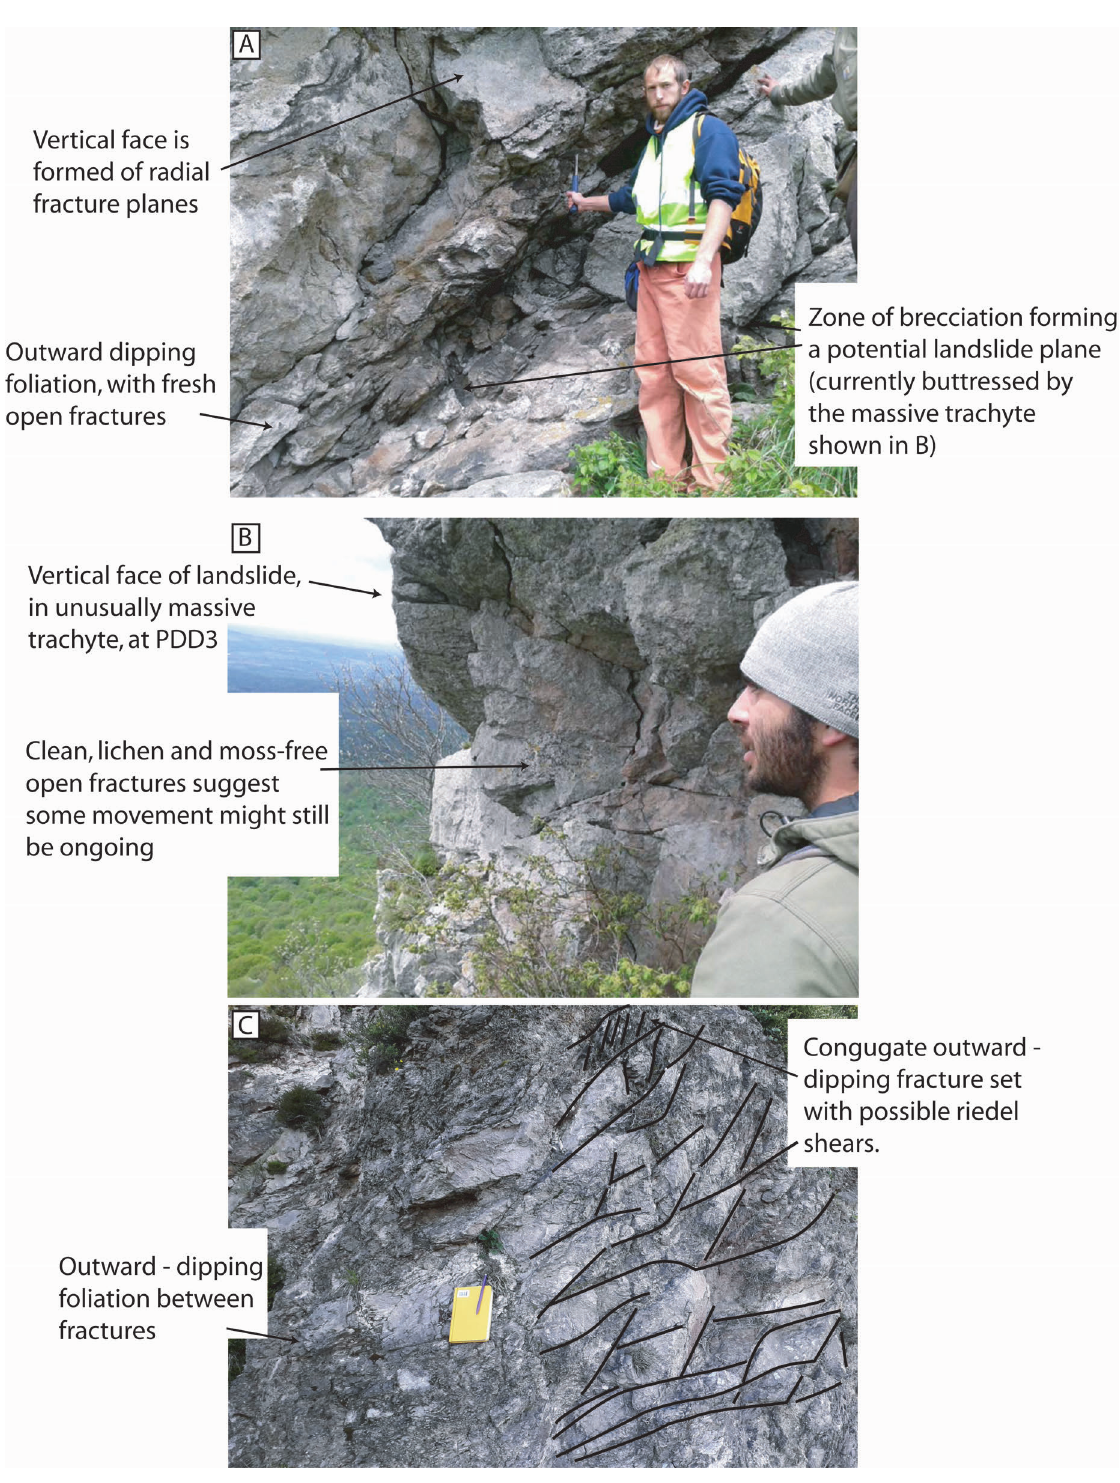
Figure 9: Pictures of the Puy de Dôme outcrops. [A] Fresh open fractures that are parallel to the magmatic foliation in the downslope-dipping breccia zone near sample site PDD5. [B] Massive buttress at PDD3, which is an unusually poorly foliated or fractured outcrop and which buttresses the potential landslide planes shown in [A]. This vertical face is probably the side wall of a landslide scar, which formed the elongate gully. The ope fractures are clean with no lichen, suggesting recent formation. [C] Outcrop of lava, 200 m down road on south side of Puy de Dôme. Here the trachyte lava shows the typical foliation, and outward-dipping conjugate fractures, with steeper planes as Riedel shears. While fractured, the outcrop is one coherent rock mass, suggesting that it deformed while still ductile and hot at low strain